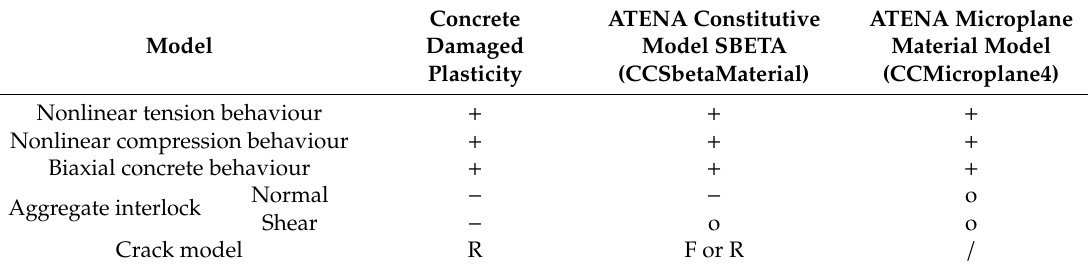
Table 1. Rating of material models against di ff erent